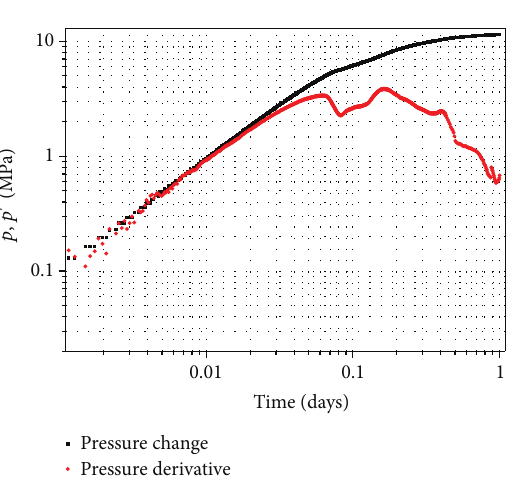
Figure 11: Measured pressure change and pressured derivative curves for Test2.